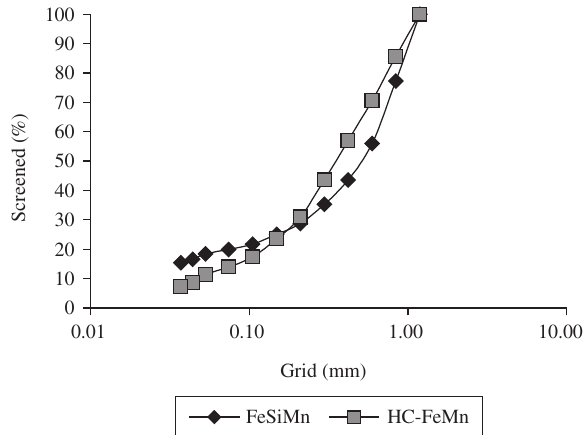
Figure 1. Particle size distribution of FeSiMn and HC-FeMn (for particles <1.18 mm).